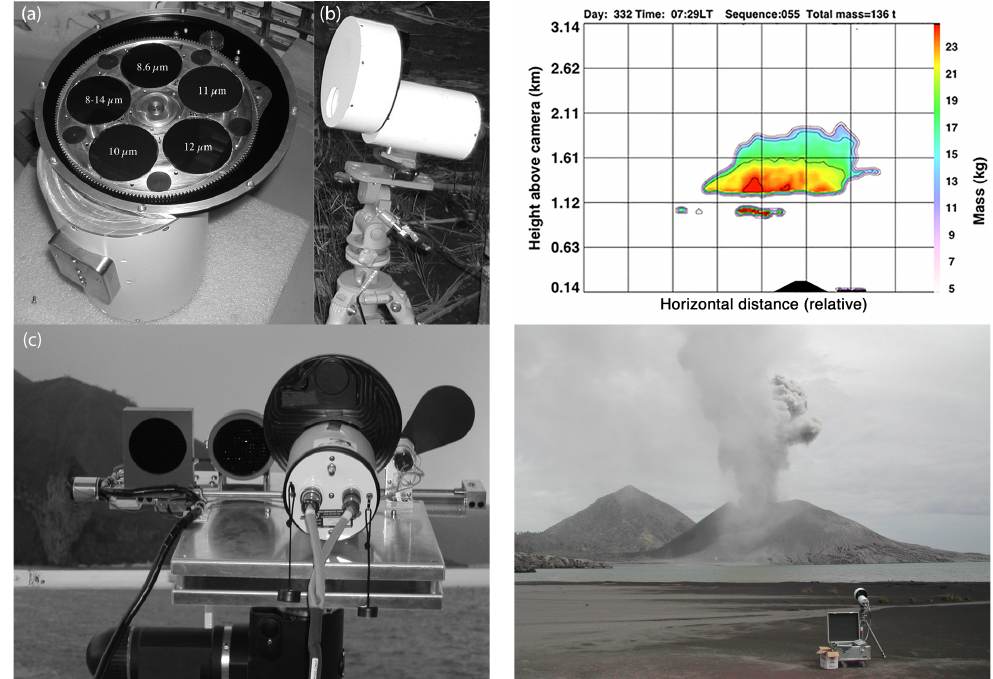
Figure 2. Left (a) and (b): The Ground-based Infra-Red Detector (GbIRD) Figure 2. Left ( a ) and ( b ): The Ground-based Infra-Red Detector (GbIRD) with five filters used for detecting ash from the ground. Note that at least three wavelengths are required and four is preferable. with five filters used for detecting ash from the ground. Note that at least ( c ) A calibration rig is installed in front of the camera module to ensure accurate temperature readings. three wavelengths are required and four is preferable. A calibration rig 1 km from Tavurvur volcano, Rabaul, PNG. Upper right: Ash mass Lower right: GbIRD placed ∼ is installed in front of the camera module to ensure accurate temperature retrieval from the ground-based readings. Lower right: GbIRD placed 1 km from Tavurvur volcano, Rabaul, ∼ PNG. Upper right: Ash mass retrieval from the ground-based camera.